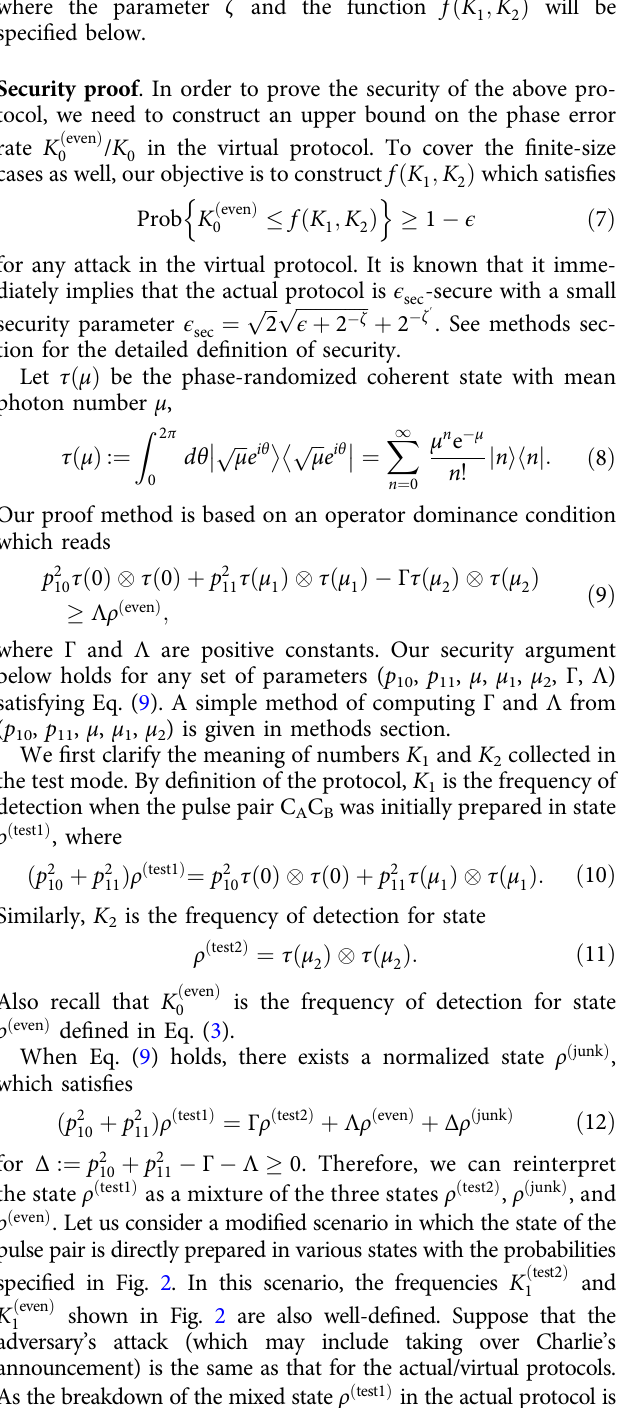
ffiffiffiffiffiffiffiffiffiffiffiffiffiffiffiffiffi ffiffiffiffiffiffiffiffiffiffiffiffi